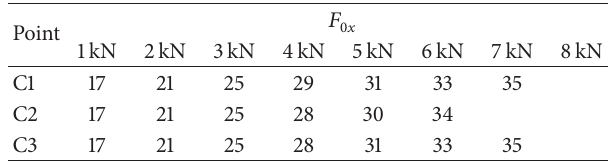
Table 5: The vibration frequency of the C1 point for rectangle Xing Yida membrane under the concentrated impact loading (Hz) ( 𝐹 0𝑥 = 𝑎 = 1.2 m, 𝑏 = 0.8 m). 𝐹 0𝑦 ,